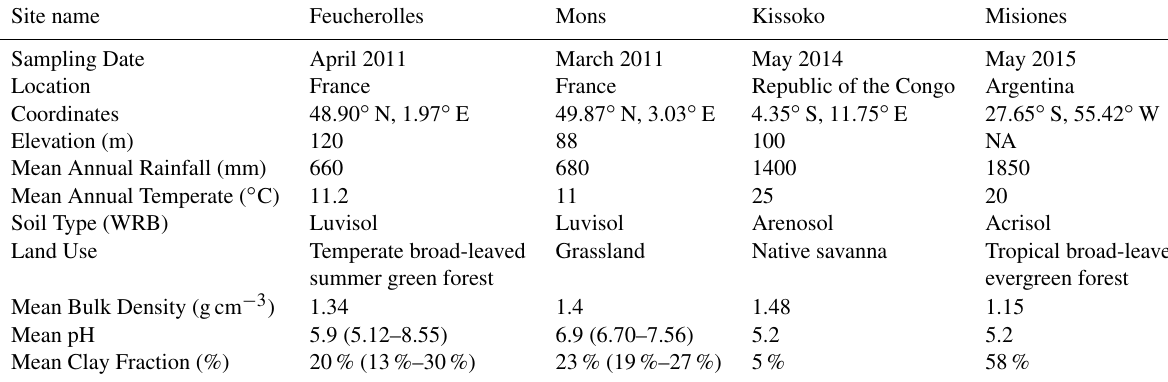
Table 1. General description of the studied sites. The mean bulk density, pH and clay fraction values calculated from the different soil layer depths available from the data were used as input for each site. For the Mons and Feucherolles sites, min and max values of pH and clay fraction are provided between brackets.